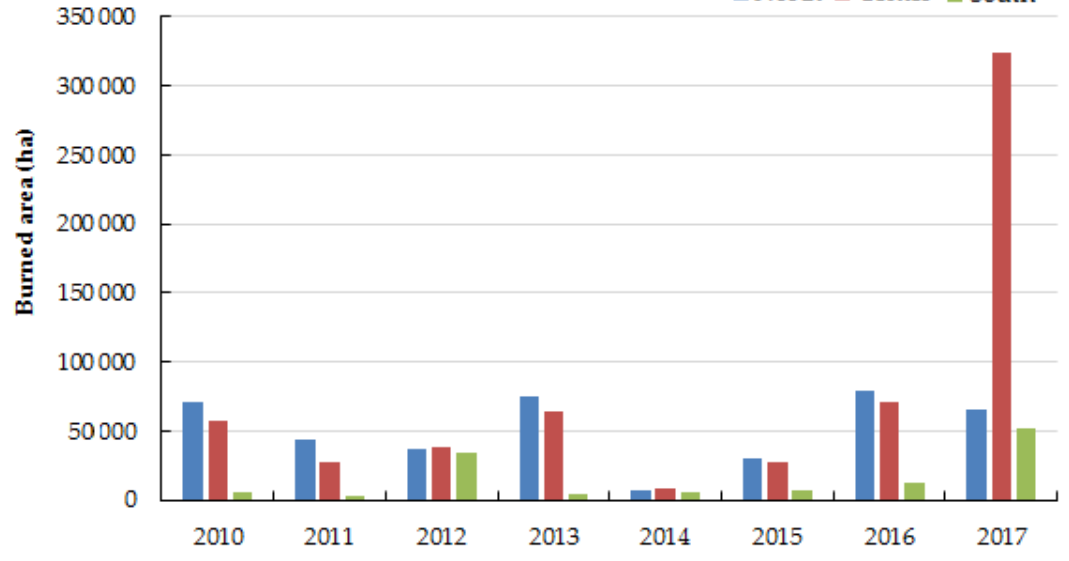
Figure 1. Levels of total burned area (ha) in the northern, central, and southern regions of Portugal between 2010–2017.